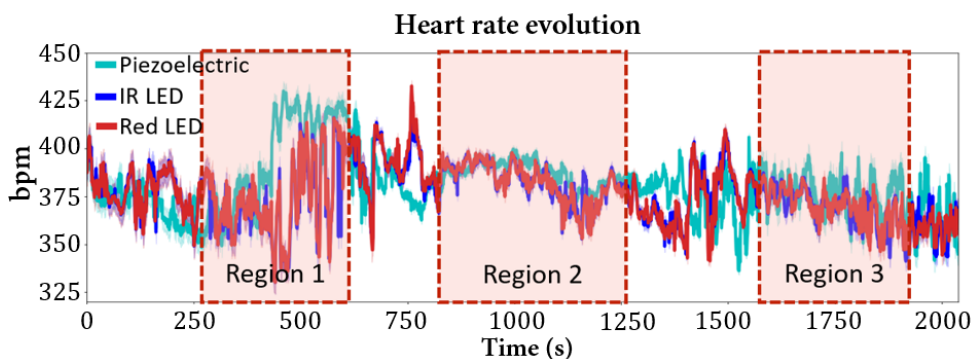
Figure 10. Heart rate evolution (Mouse 1) through sevoflurane concentration changes. The high- lighted regions represent moments where the anesthetic concentration did not change: Region 1—stable zone at 2% of sevoflurane; Region 2—stable zone at 1.5% of sevoflurane; Region 3—stable zone at 4% of sevoflurane. Table 2. Heart rate (HR) values for the several concentrations of sevoflurane. P: value obtained with the piezoelectric sensor data; IR: value obtained with the IR LED data; Red: value obtained with the Red LED data. Mouse Sevoflurane (%) HR ± ∆ HR